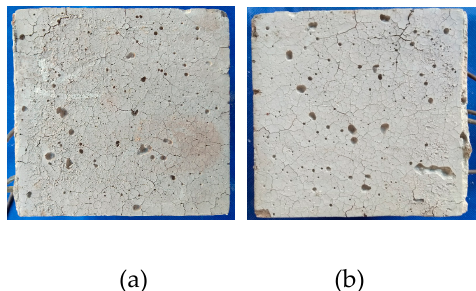
Figure 10. The explosion process of the carbon fiber specimens with different water contents: ( a ) Dry and ( b ) natural.